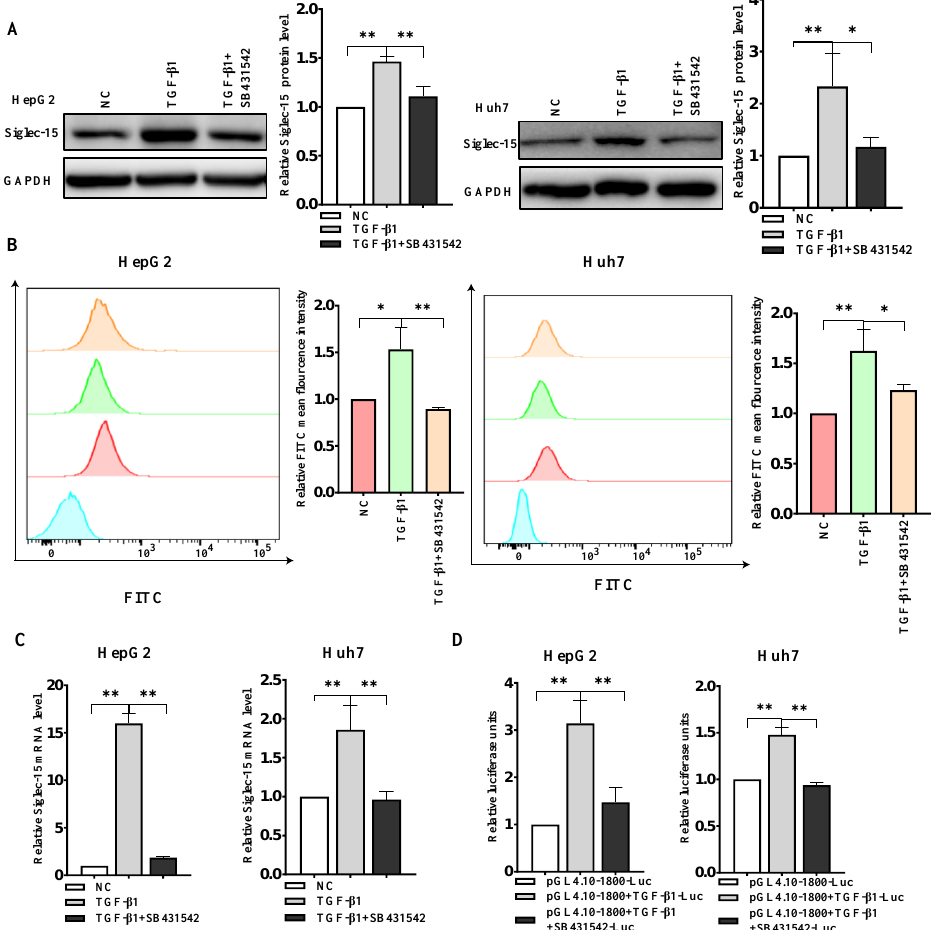
Figure 4. TGF- β 1 upregulated Siglec-15 expression in HCC cells. ( A ) Western blot analysis of Siglec- 15 protein levels in the cells treated with TGF- β 1 (50 ng/mL) for 24 h in the absence or presence of 8 mM SB431542 for 12 h. ( B ) Flow cytometric analysis of Siglec-15 expression in the HepG2 and Huh7 cells with the same treatment as specified above. * p < 0.05; ** p < 0.01. NC stands for untreated control. ( C ) Quantitative real-time PCR analysis of Siglec-15 mRNA expression in the same treated cells. ( D ) Dual-luciferase reporter assay for TGF- β 1 sensitivity in HCC cells. Cells were transfected with the luciferase reporter vector and then treated with or without 50 ng/mL TGF- β 1 for 24 h in the absence or presence of 8 mM SB431542 for 12